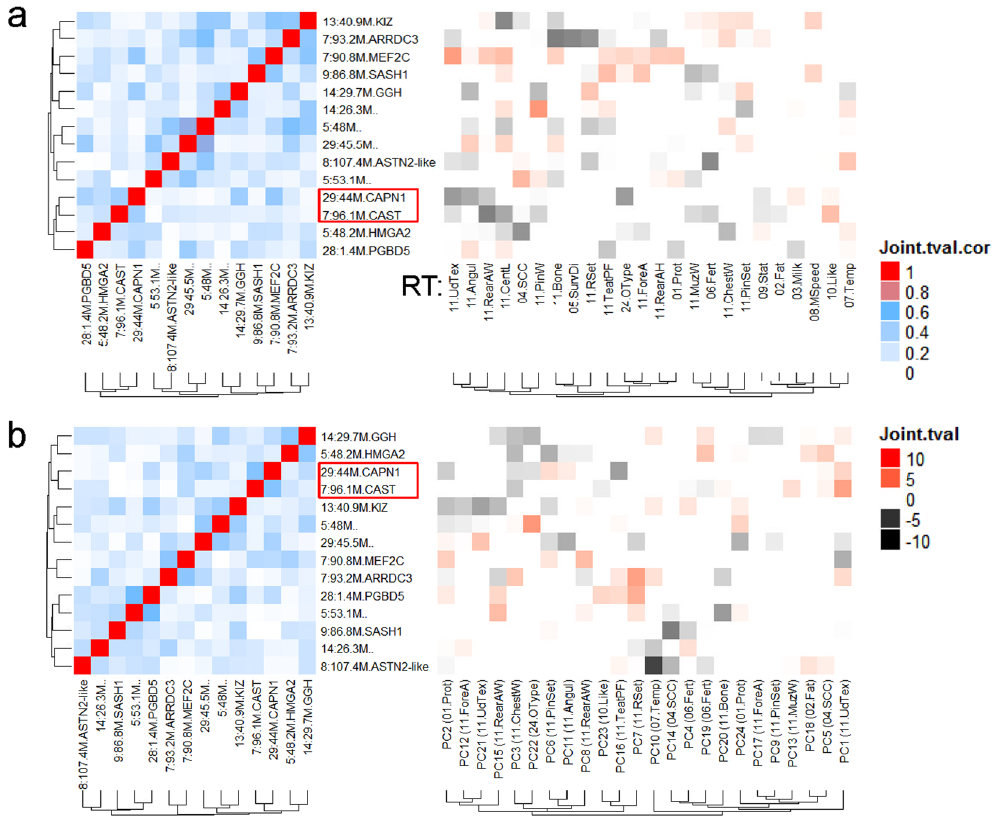
Figure 6. Clustering of the dairy-beef overlapped SNPs on raw traits (RTs, a ) and principle components (PCs, b ) of the dairy discovery population. Loci displaying similar effect clustering patterns across RT, PC and Choleskey transformed traits (Supplementary Figure S4) were highlighted in red boxes. Loci labels on the Y-axis were the same for both left (correlation of SNPs’ effects) and right (SNP’s effects on traits) panels. t values with absolute values > = 1 and validated for consistent effect directions between the discovery and validation populations were coloured. The RT associated with the top factor loading value of each PC was shown in the parentheses on the right panel (Supplementary Table